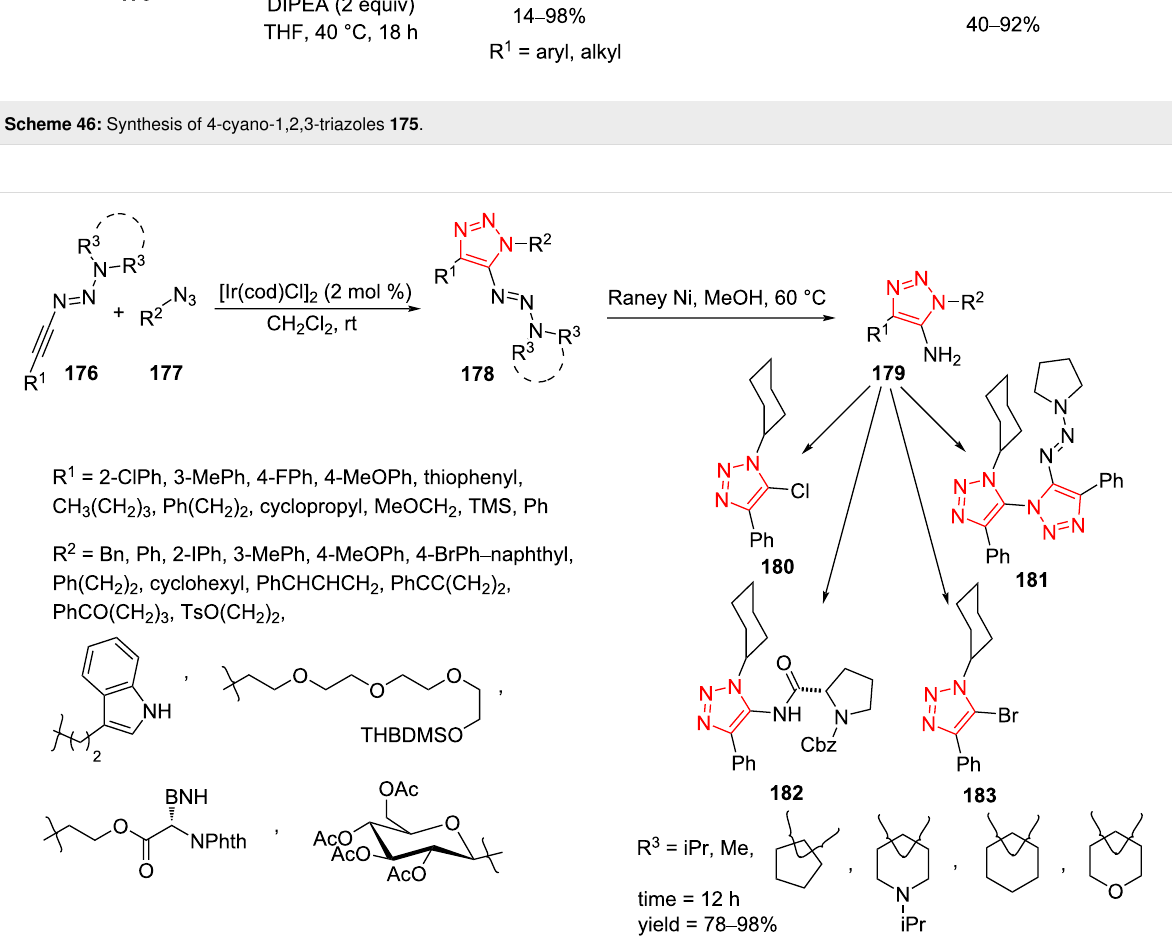
Scheme 47: Synthesis of functionalized triazoles from the reaction of 1-alkyltriazenes 176 and azides 177 and synthetic route for functionalization toward diverse triazoles 179 – 183